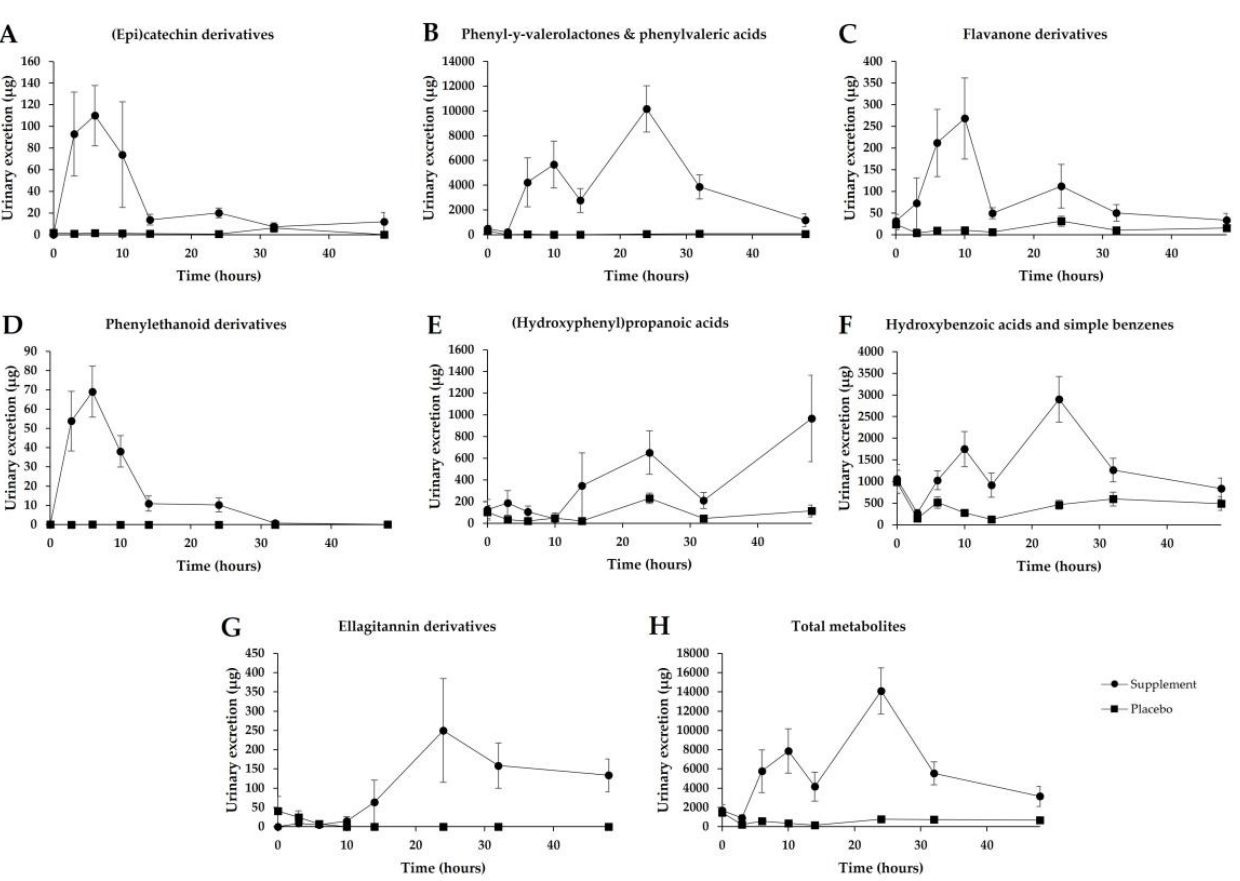
Figure 6. Urinary excretion in placebo ( n = 10) and supplemented subjects ( n = 10) over a 48 h period. ( A ) (Epi)catechin derivatives; ( B ) Phenyl-y-valerolactones and phenylvaleric acids; ( C ) Flavanone derivatives; ( D ) Phenylethanoid derivatives; ( E ) (Hydroxyphenyl)propanoic acids; ( F )